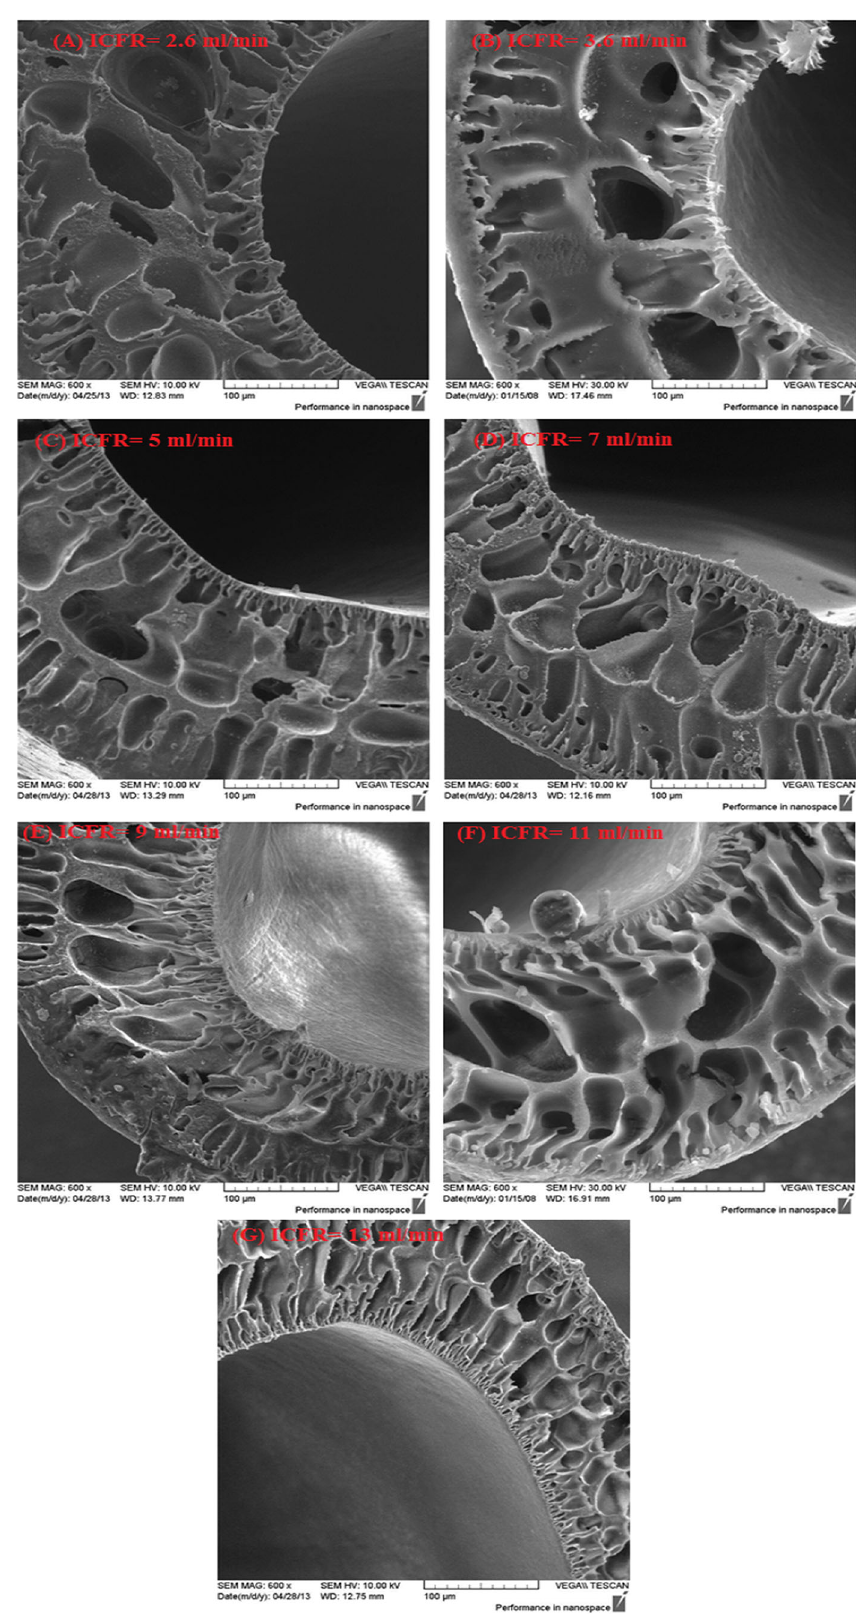
Fig. 2 Cross-section